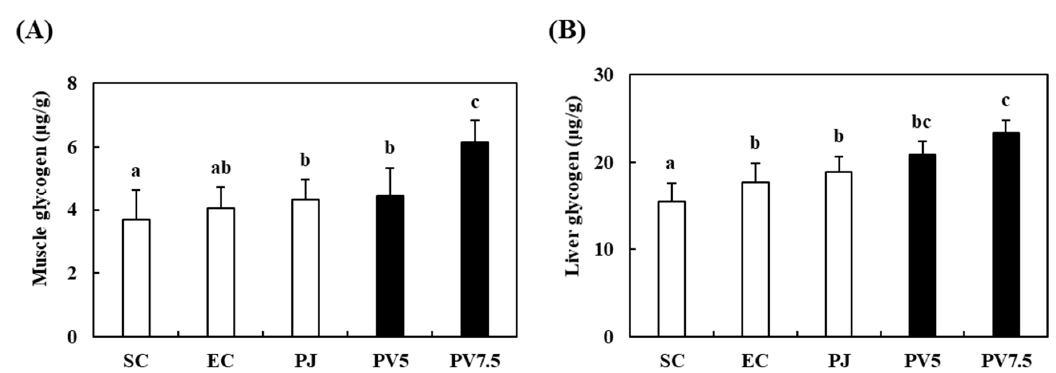
Figure 5. E ff ect of PV on glycogen accumulation of ( A ) muscle and ( B ) liver in exhausted rats. Data values are expressed as the means ± S.E. ( n = 6). SC: sedentary control, EC: exercised control, PJ: Prunus mume juice, PV5: 5% Prunus mume vinegar drink, PV7.5: 7.5% Prunus mume vinegar drink. Di ff erent letters on the bar are significantly di ff erent ( p < 0.05).